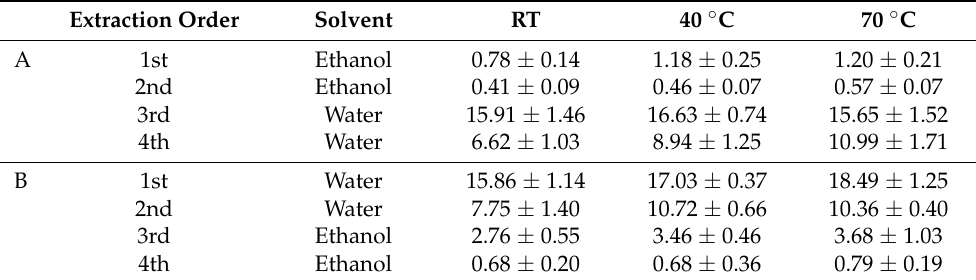
Table 1. Extraction yield as g of extract per 100 g dw for the different fractions obtained. Results are shown as the mean ± standard deviation ( n = 4). RT is defined as room temperature. A and B represent the different solvent order.